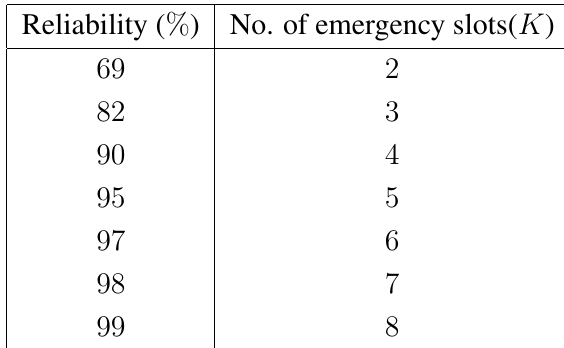
Table 2. Number of emergency slots for different